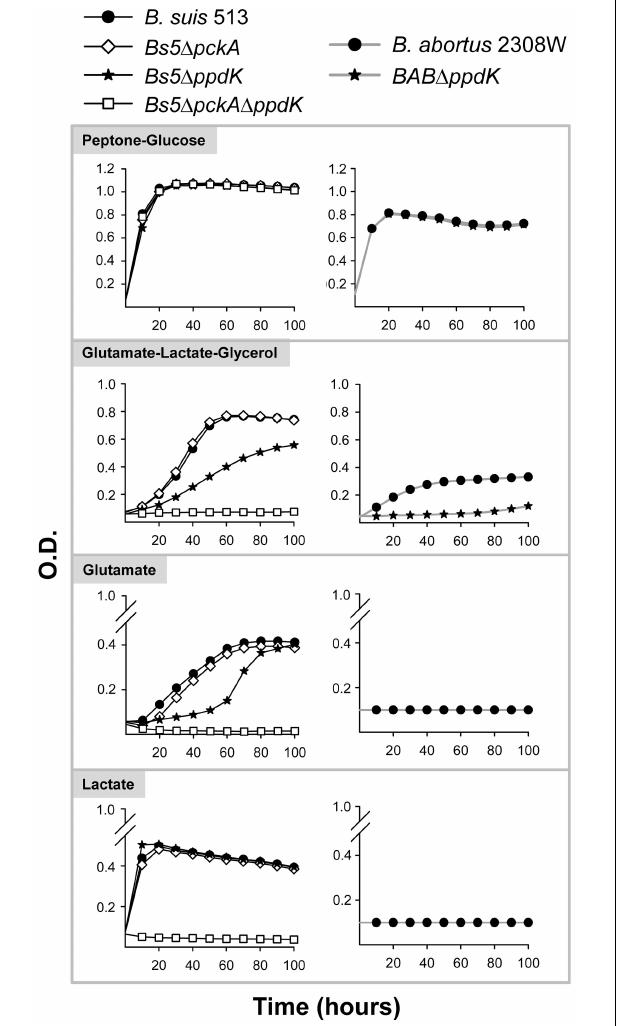
FIGURE 3 | Growth curves in peptone-glucose, glutamate-lactate-glycerol, glutamate, and lactate of B. suis 513 and mutants Bs5 (cid:49) fbp , Bs5 (cid:49) glpX , and Bs5 (cid:49) fbp (cid:49) glpX , and B. abortus 2308W and mutant BAB (cid:49) fbp (cid:49) glpX. Each point represents the mean ± standard error (error bars are within the size of the symbols) of an experiment performed in technical triplicates. The experiment was repeated three times with similar results.